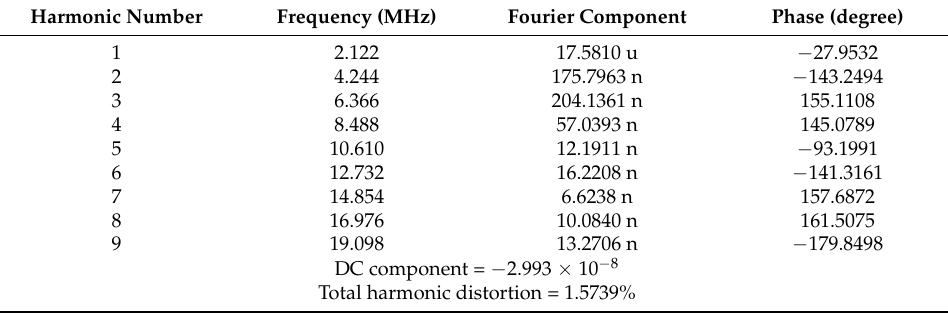
Table 6. Total harmonic distortion analysis of I o 1 in Figure 3.